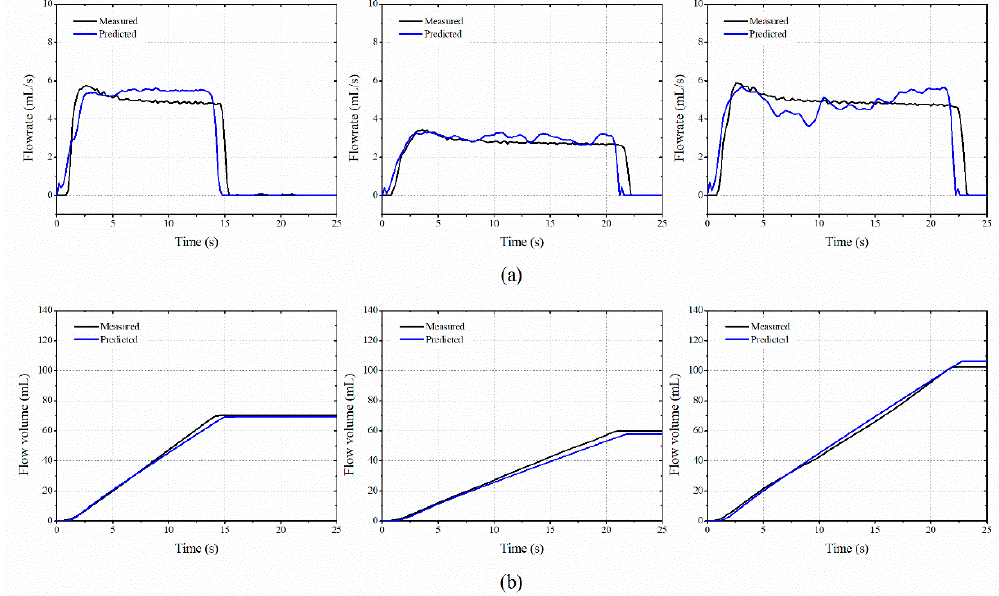
Figure 10. Comparison of the measured water flow rate by using the proposed LSTM and vibration responses: ( a ) mass flow rate and ( b ) total mass flow.